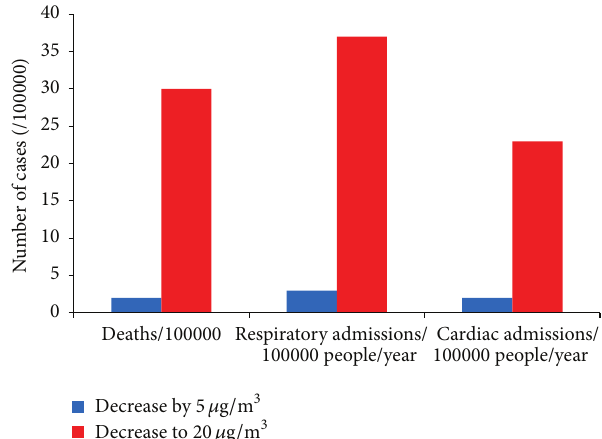
Figure 3: Potential benefits of reducing annual PM 10 levels on mortality and on cardio respiratory morbidity in Bejaia